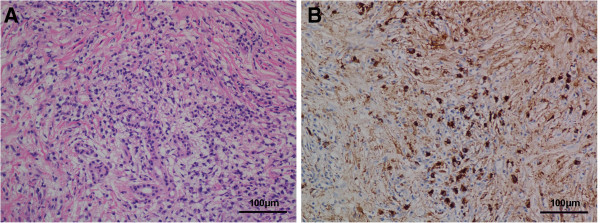
Hematoxylin and eosin (HE) staining and immunohistochemistry (IHC) of the pancreatic tissue. HE stain (A, ×200) showed dense lymphoplasmacytic infiltration and fibrosis. IHC (B) showed abundant IgG4+ plasma cell infiltration.